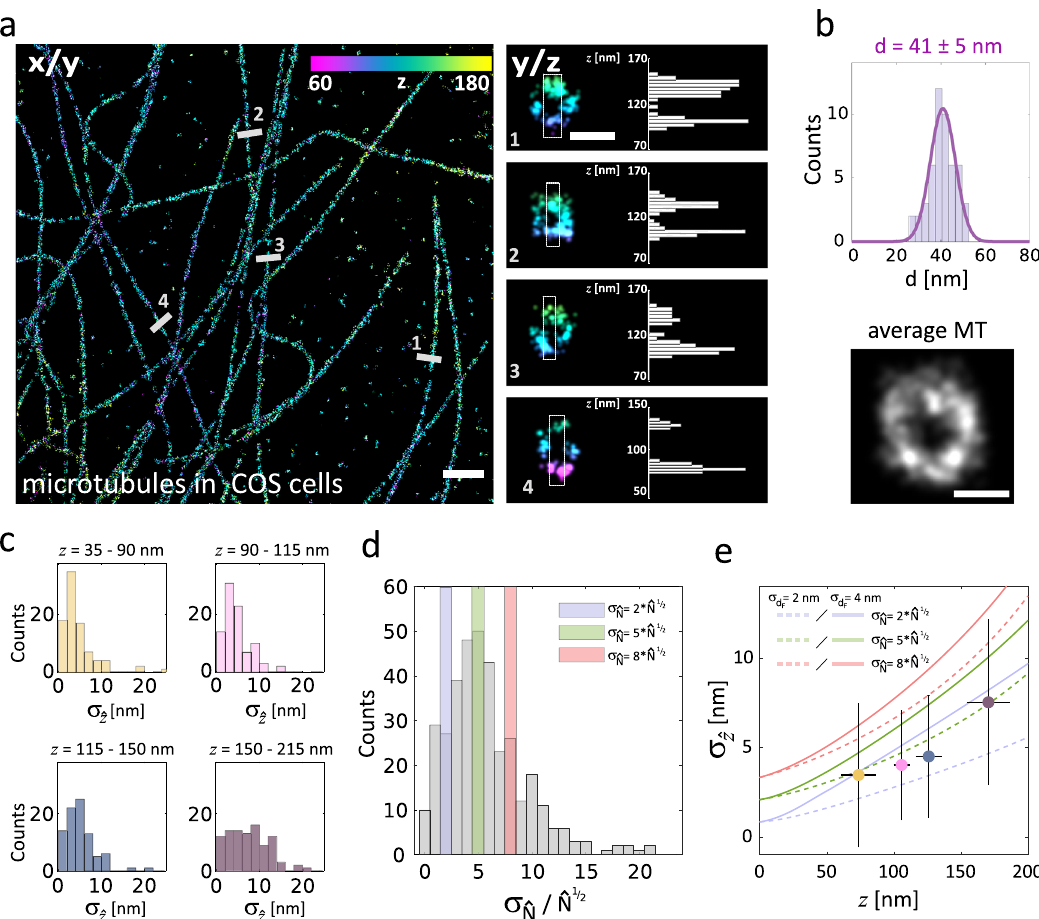
Fig. 3 Microtubules immunolabeled for DNA-PAINT super-resolved in 3D using SIMPLER. a Microtubules in COS-7 cells. Left: top view. Right: magni fi ed side-views along the numbered lines in the top view, together with the axial pro fi le of the boxed areas. Top- and side-views have the same z -colour scale. Three independent experiments were performed with similar results. b Distribution of microtubule diameters ( n = 50), with an average of 41 nm and a standard deviation of 6 nm. An average ( n = 8) microtubule pro fi le is also shown. c Histograms of σ ^ z at different z- positions, obtained experimentally from 366 DNA-PAINT single-molecule traces. Data include traces from microtubules in COS-7 cells, as well as from spectrin in hippocampal neurons (Fig. 2d). ffiffiffiffi p ^ N to remark how much larger is σ ^ N with respect to the expected d Histogram of the experimentally determined variance of ^ N ( σ ^ N ), expressed in units of p ffiffiffiffi ^ N ). The values 2, 5 and 8 are highlighted. The variance was obtained from the same 366 single-molecule traces as those theoretical lower bound ( σ ^ N ¼ analysed in c . e Median σ ^ z values located in the median z -position of each interval de fi ned in c , overlapped with theoretical curves of σ ^ z for ^ N 0 = 51,000 ffiffiffiffi p ^ N for σ dF = 2 and 4 nm. Error bars represent the standard deviation of σ ^ z and z . The number of single-molecule traces analysed in and σ ^ N = 2 x , 5 x or 8 x each interval was 93 (for z = 35 – 90 nm); 90 (for z = 90 – 115 nm); 87 (for z = 115 – 150 nm); and 96 (for z = 150 – 225 nm). Data includes localizations from three biologically independent samples (immunolabeled microtubules in two independent COS-7 cells and immunolabeled spectrin in a hippocampal neuron). Scale bars represent 1 µ m ( a , top view); 50 nm ( a , side view) and 25 nm ( b ). Number of localizations kept after frame- fi ltering step: a (1) 176 (out of 292), (2) 257 (out of 433), (3) 131 (out of 294) and (4) 85 (out of